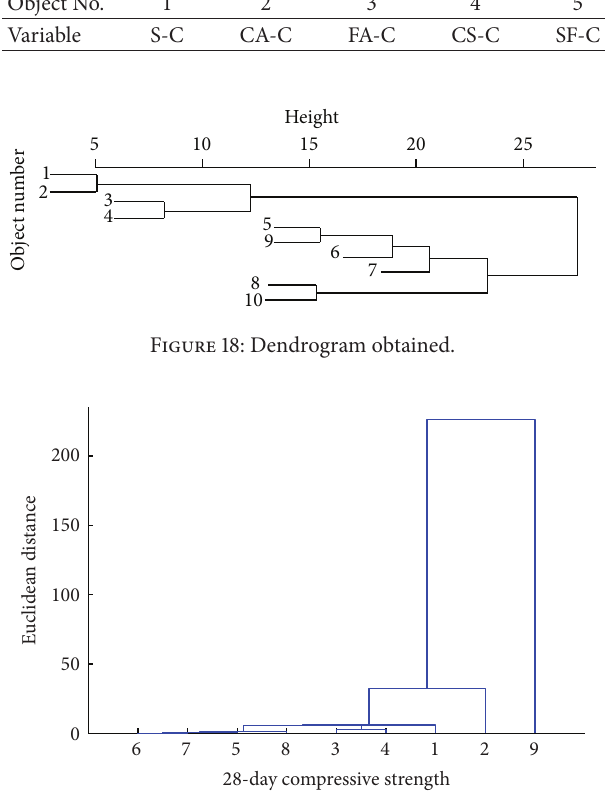
Figure 19: Dendrogram obtained (with portions enlarged).